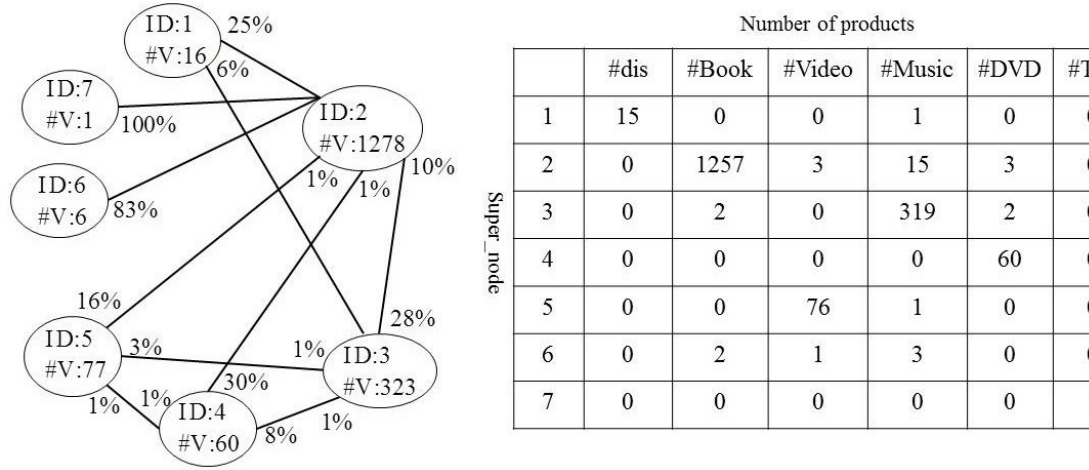
Figure 7: The third summary graph of the size of 7